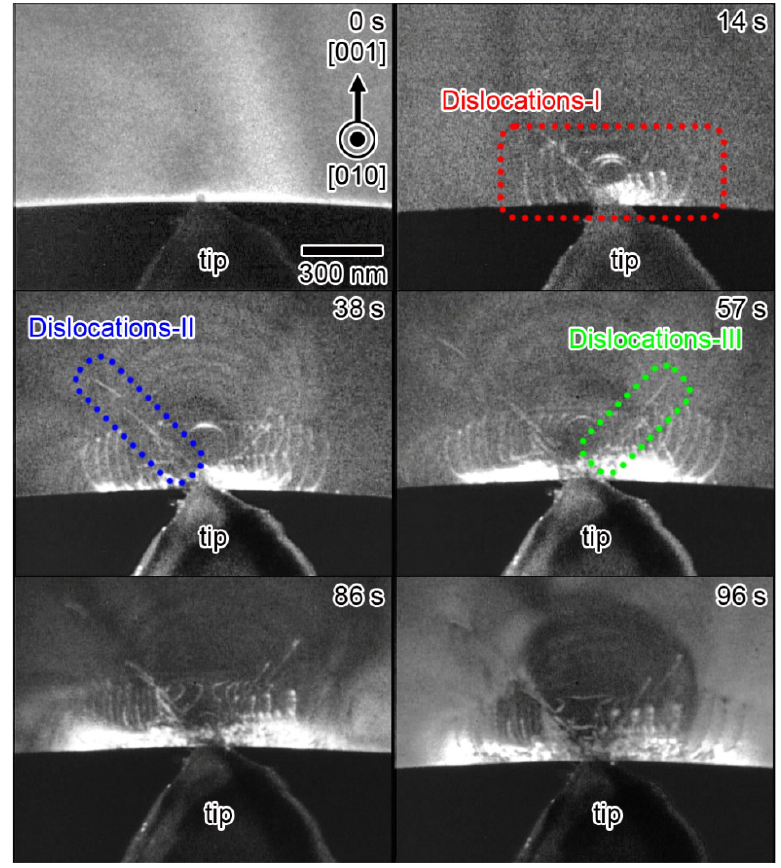
Figure 71. Sequential dark-field TEM images captured from the movie recorded during the nanoindentation experiment. The image was taken using g = 002. The broken lines indicate three different kinds of dislocations. Adapted with permission from Ref. [108].